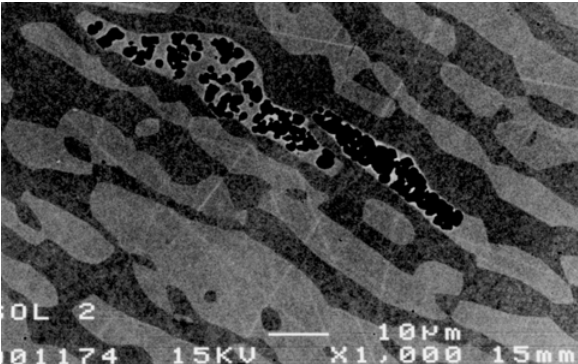
Figure 7. Localized corrosion (black spots) on austenite of the solution annealed 3RE605 alloy after the cyclic potentiodynamic polarization test. SEM - primary electrons image.